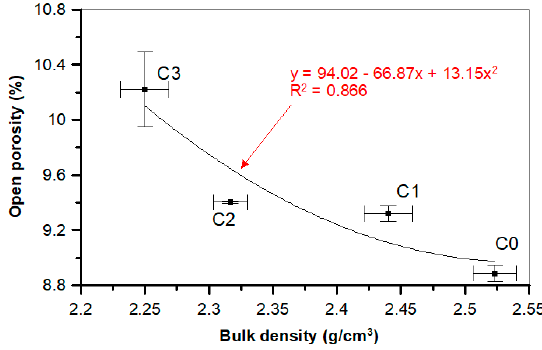
Figure 18. Relationship between the concrete’s bulk density and open porosity.